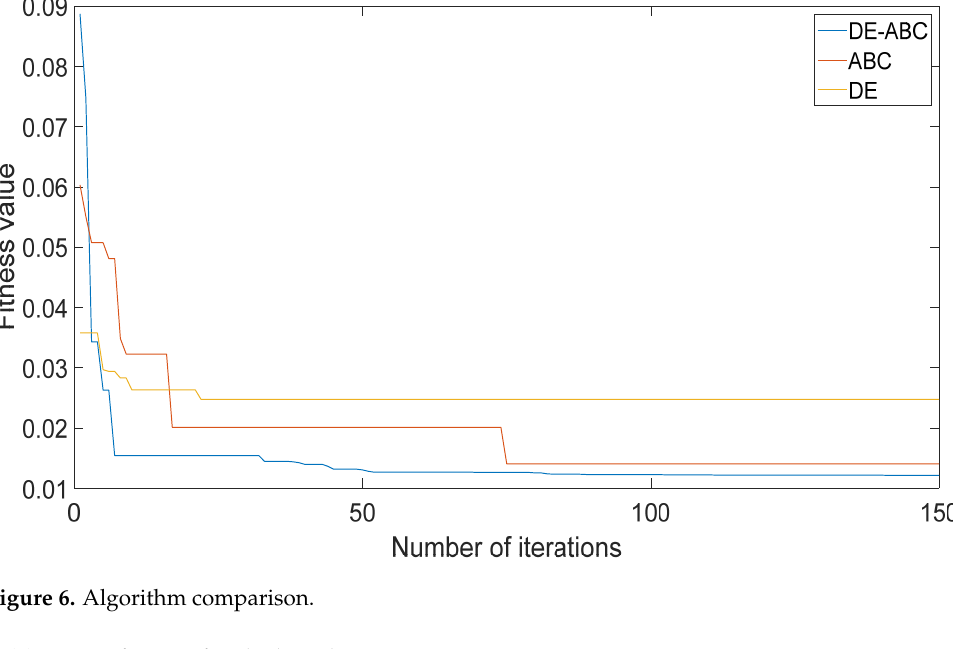
Figure 6. Algorithm comparison. Table 1. Best fitness of each algorithm.